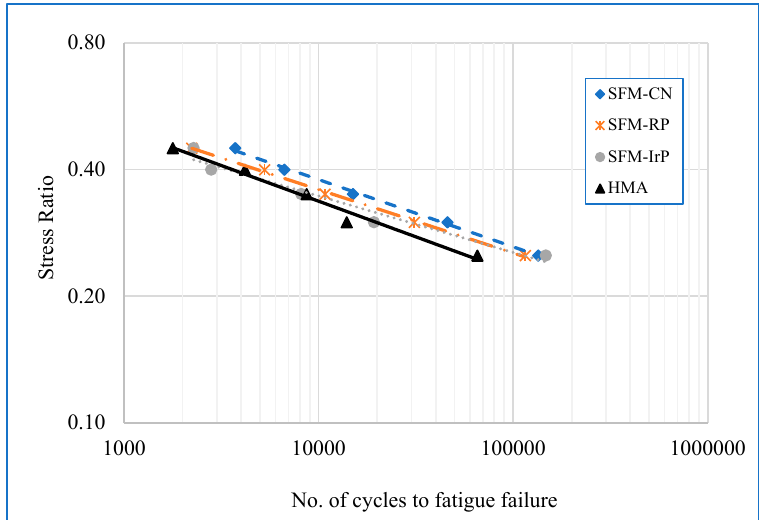
Figure 9. Relationship between the fatigue life and the stress ratio .